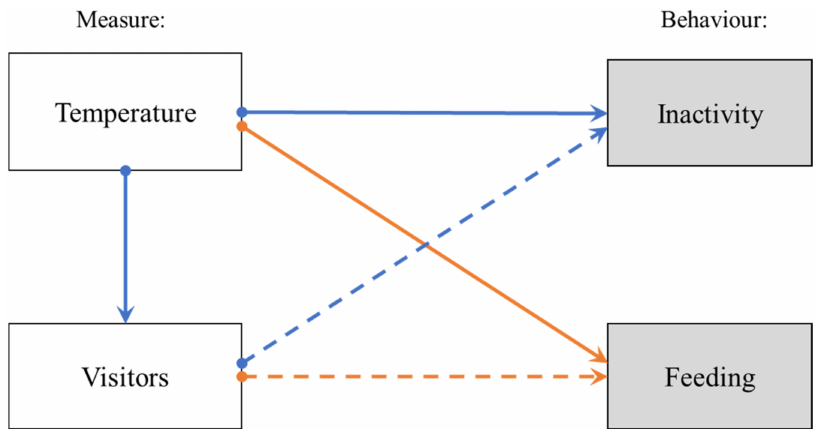
Figure 10. The influence of temperature on visitor numbers and flamingo behaviour. Blue: positive relationship; orange: negative relationship. Solid line: known effect; dashed line: apparent effect. Visitor presence appeared to be associated with increased inactivity and decreased feeding. However, visitor presence is itself influenced by temperature. Temperature is known to influence behaviour in the same way that visitors appeared to. The apparent effects of visitors on behaviour may therefore be due to the indirect effects of temperature. Temperature and visitor numbers are correlated and are explaining the same variation in